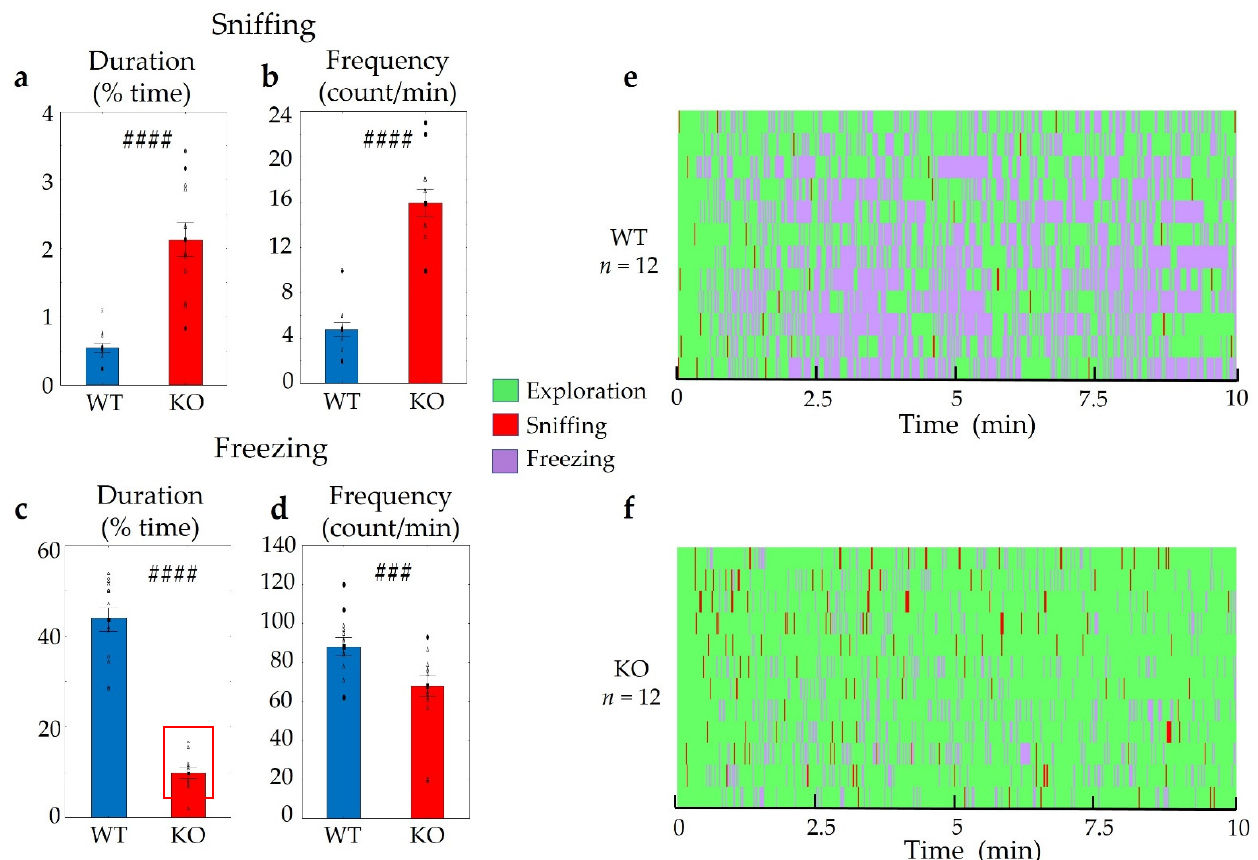
Figure 4. Behavioural differences in Trpa1 wild-type (WT) and knockout (KO) mice triggered by the fox odour, 2-MT. Remarkable differences were established in the duration and frequency of sniffing the odour holder ( a , b ) and freezing behaviour ( c , d ) between the two groups. The Gantt diagram presents the individual animals ( e , f ). n = 12 in both (WT and KO) groups, the symbol # shows a significant difference between the two genotypes, in cases with ### p < 0.001, and #### p < 0.0001. Blank triangles represent individual values while dark spots show outliers (characterized by a higher or lower value than mean ± 2 standard deviation (SD)).